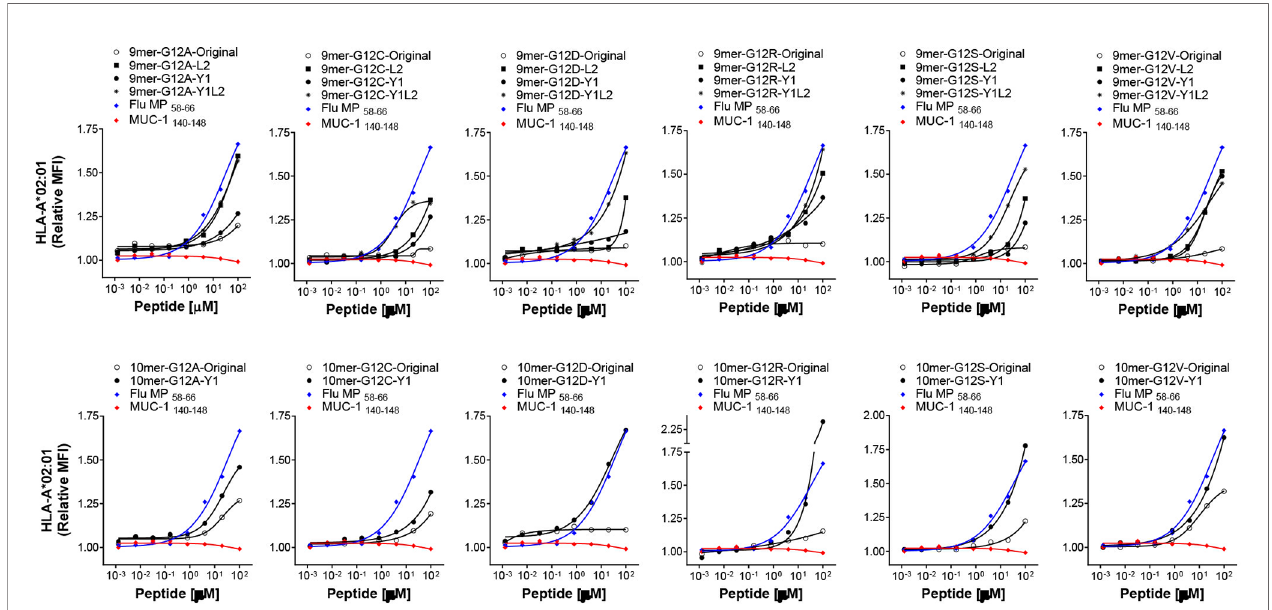
FIGURE 2 | HLA-binding of anchor-modi fi ed RAS-mutant peptides. MHC-I Stabilization assays using TAP-de fi cient T2 cell lines expressing HLA-A*02:01 were carried out to assess binding of 9-and 10-mer anchor-modi fi ed peptides representing 6 RAS mutants. The binding of each peptide was analyzed three times and the mean of all of the experiments performed is shown. MUC-1 140-148 and Flu-MP 58-66 peptides were used as negative and positive control,